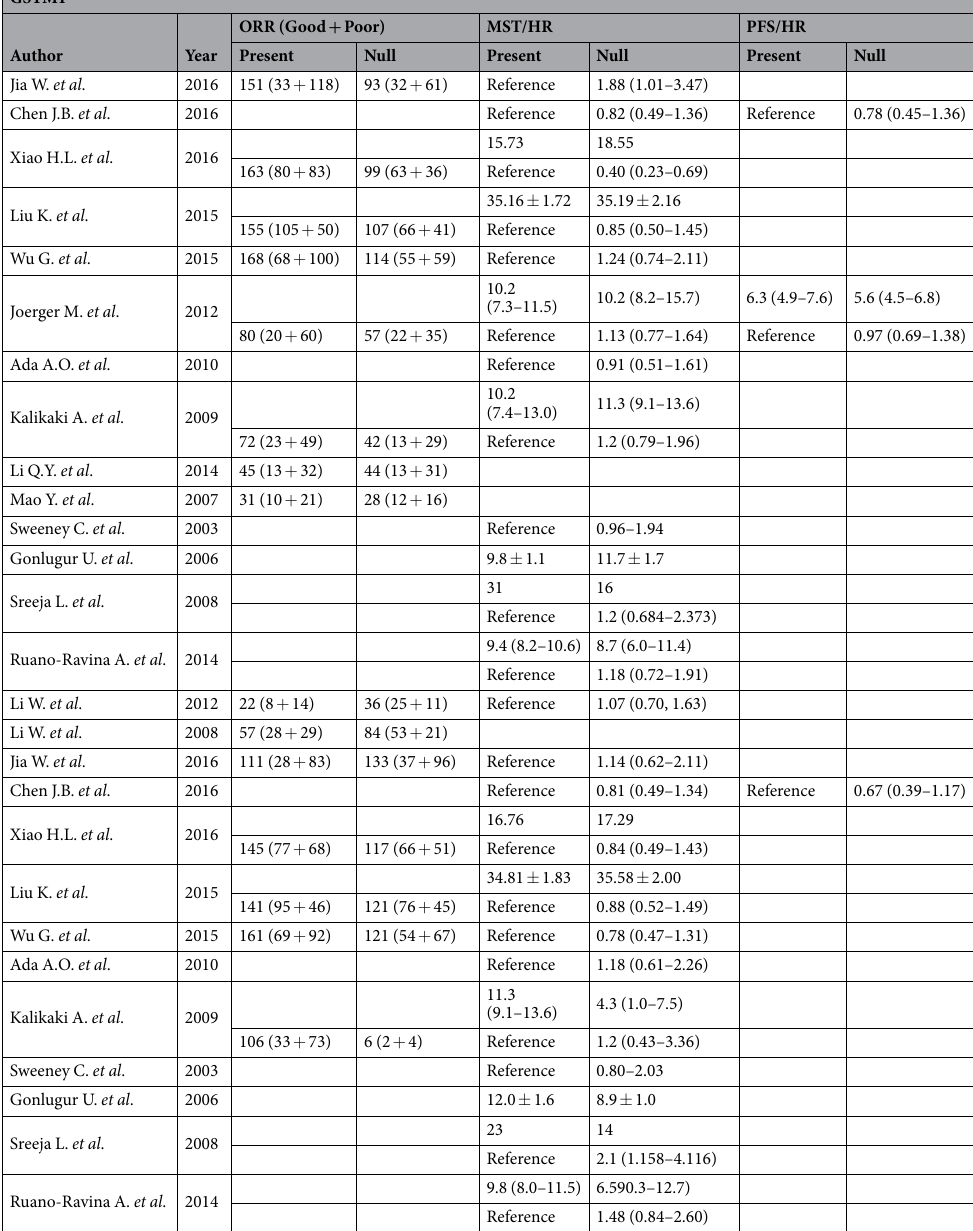
Table 3. Association between the GSTM1 and GSTT1 polymorphisms and objective response rate, median survival time, median time to progression and median progression-free survival of platinum-based chemotherapy in NSCLC patients. HR: hazard ratio; MST, median survival time (months); PFS, progression- free survival (months); ORR: objective response